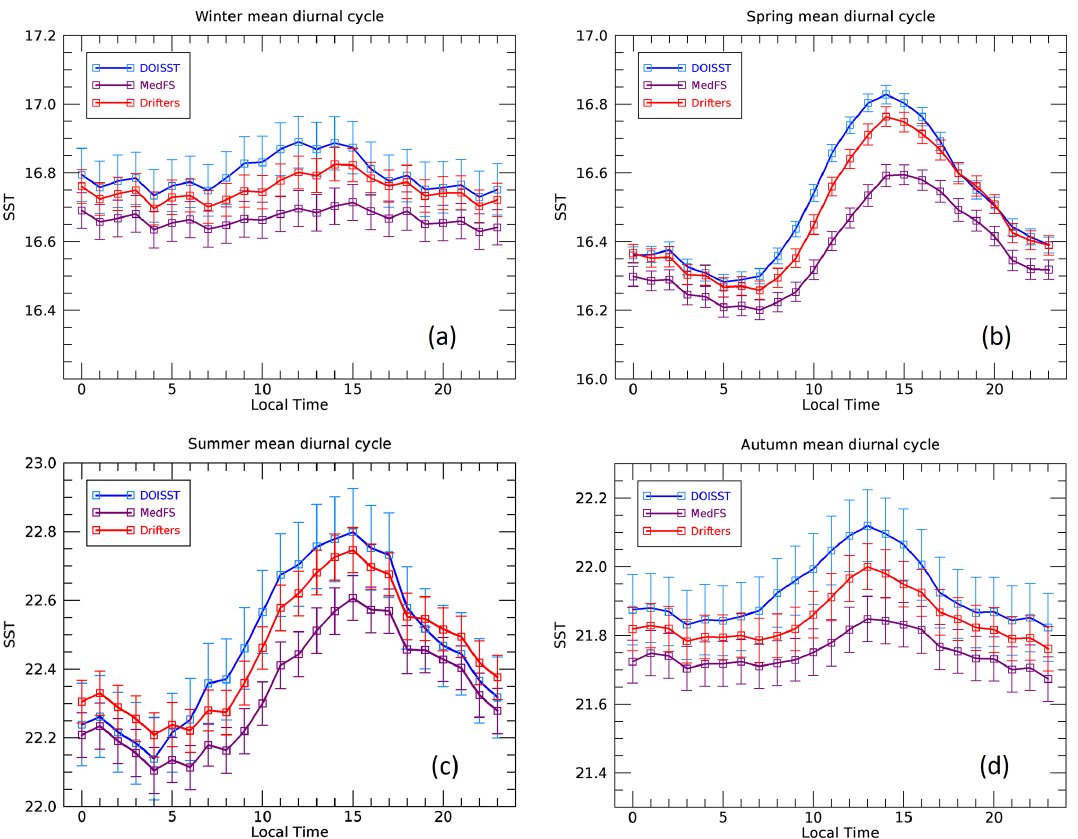
Figure 5. Seasonal mean diurnal cycle over the period 2019–2020 for MED DOISST (blue line), MedFS (purple line), and in situ (red line). (a) Winter (December to February). (b) Spring (March to May). (c) Summer (June to August). (d) Autumn (September to